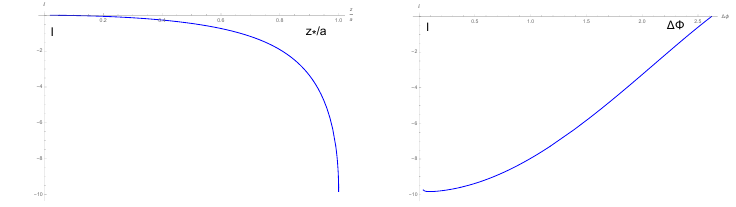
Figure 23 . Plots of free energy I T as a function of z ∗ /a (left) and as a function of ∆ φ (right). We set 16 πG N = 1 and β = 1 ∆ x